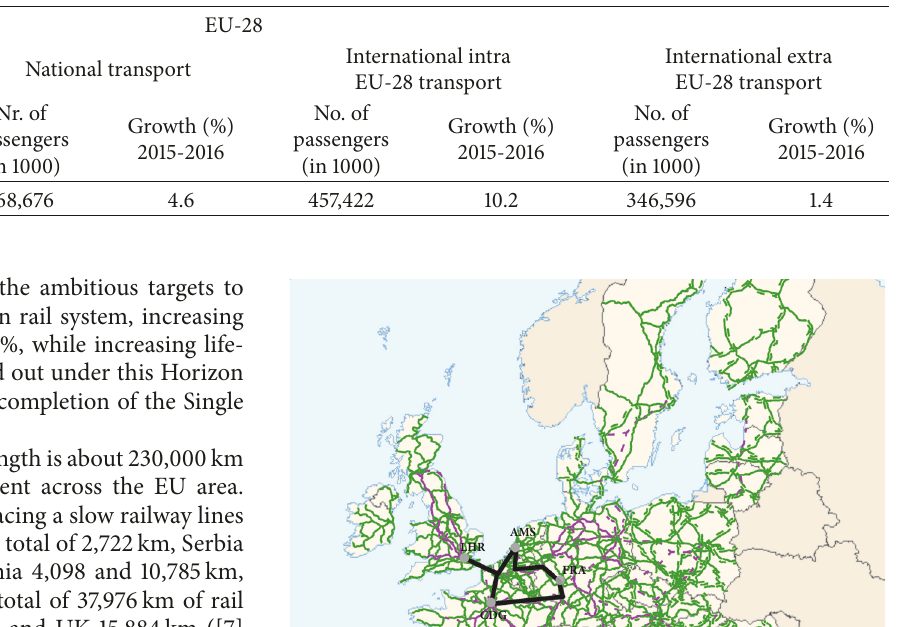
Table 1: Total number of passenger transport in EU-28 (source: [17].).